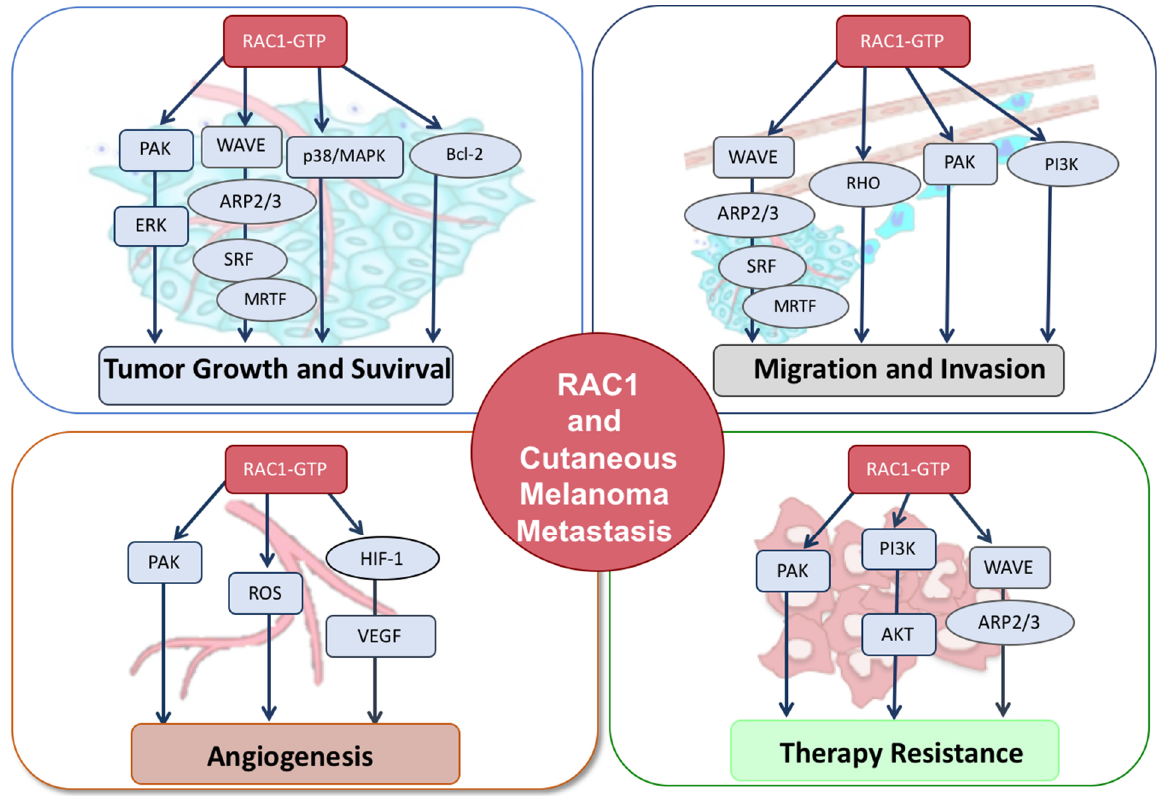
Figure 1. RAC1 signaling in metastatic cutaneous melanoma. Schematic diagram of RAC1 activation regulating tumor growth and survival, migration and invasion, angiogenesis and therapy resistance in cutaneous melanoma.